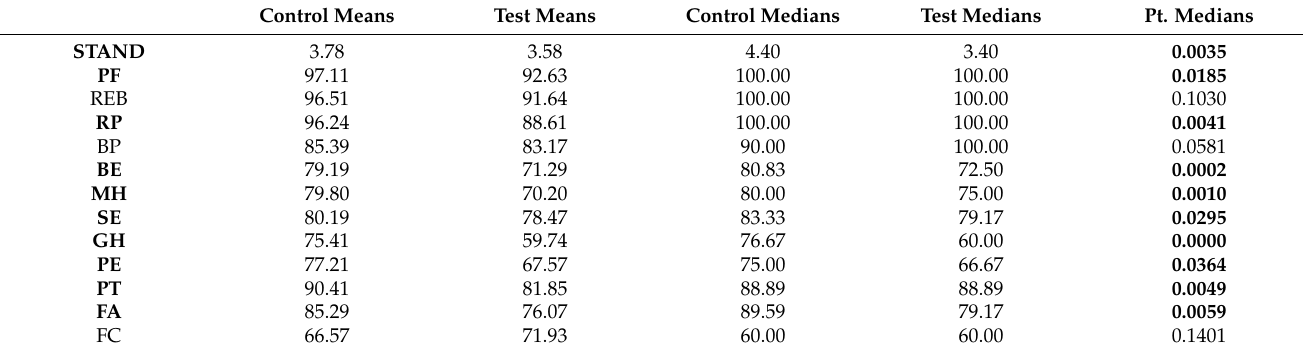
Table 3. A comparison of children suffering from adenoid hypertrophy (test group) with controls. Control Means Test Means Control Medians Test Medians Pt. Medians